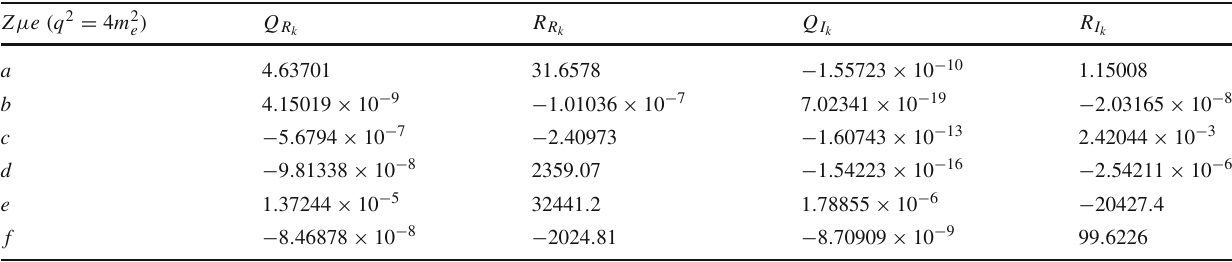
( Q I ) and R R ( R I ) coefficients of the Z μ e vertex for q 2 = 4 m 2 k k k k